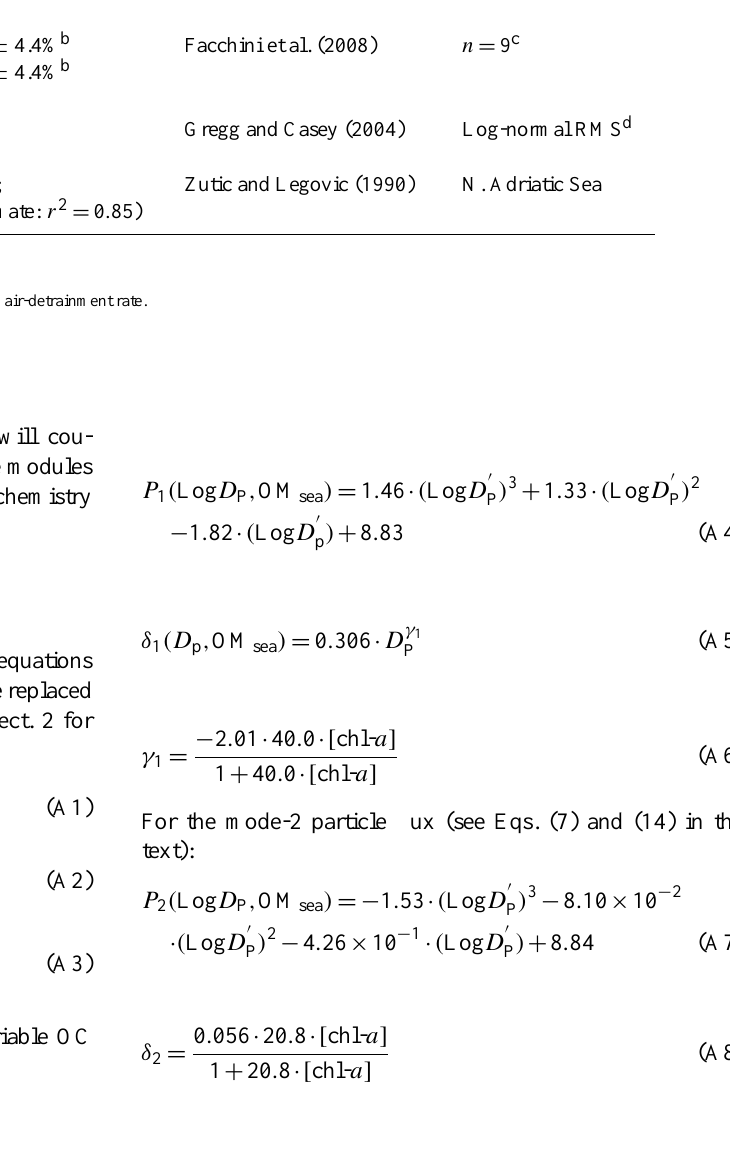
Measured Number Production Flux